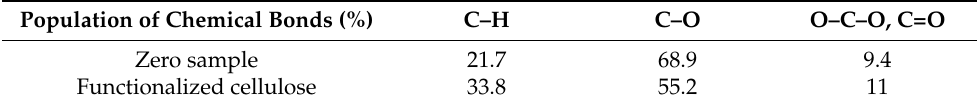
Table 3. Population of chemical bonds in the zero sample and in the functionalized